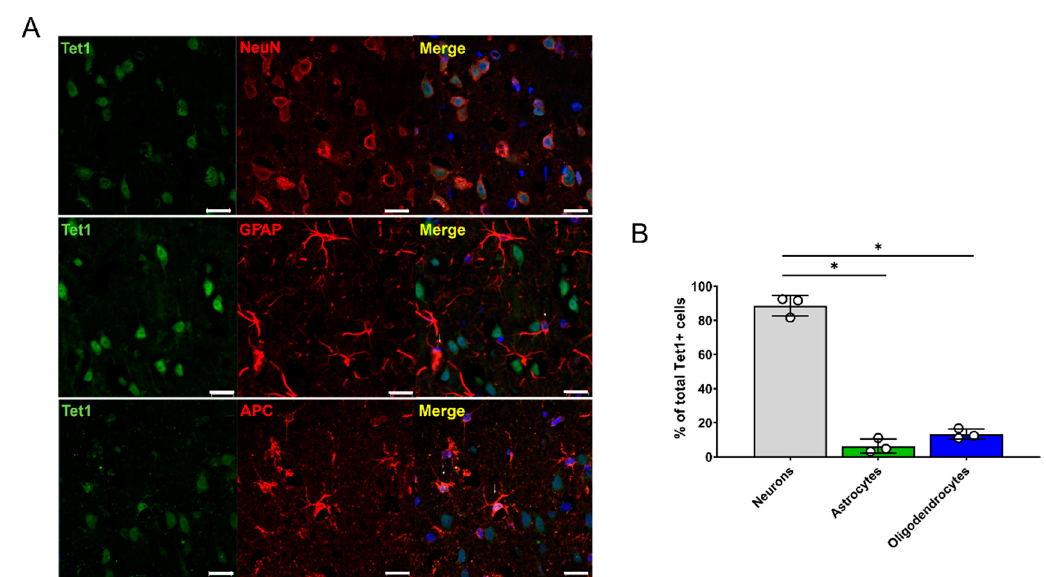
Figure 5. Distribution of Tet1 genes within neurons, astrocytes, and oligodendrocytes in the brain motor cortex 1 week after injury. ( A ) Representative immunohistochemical images of double staining of Tet1 (green) and NeuN (red), of Tet1 (green) and GFAP (astrocytes), and of Tet1 (green) and APC (red). White scale bars = 20 µm. ( B ) Percentages of NeuN-positive neurons, GFAP-positive astrocytes, and APC-positive oligodendrocytes among total Tet1-positive cells ( n = 3 per cell type); * p < 0.05 between groups by one-way analysis of variance (ANOVA) and Games-Howell post hoc tests.